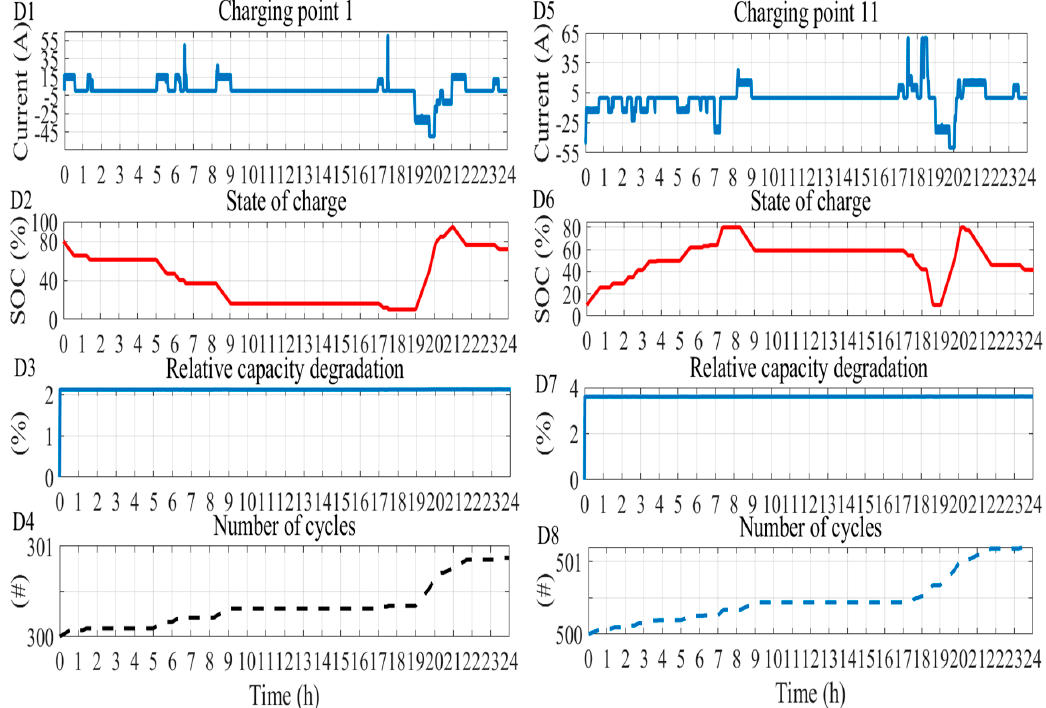
Figure 14. Comparison of the 1st and 11st EVs with different initial SoCs and cycles: ( D1 ) current profile of EV1, defined by the decentralized controller, ( D2 ) time-based SoC of EV1, ( D3 ) rate of capacity degradation of EV1, ( D4 ) number of cycles of EV1, ( D5 ) current profile of EV11, defined by the decentralized controller, ( D6 ) time-based SoC of EV11, ( D7 ) rate of capacity degradation of EV11, ( D8 ) number of cycles of EV11.